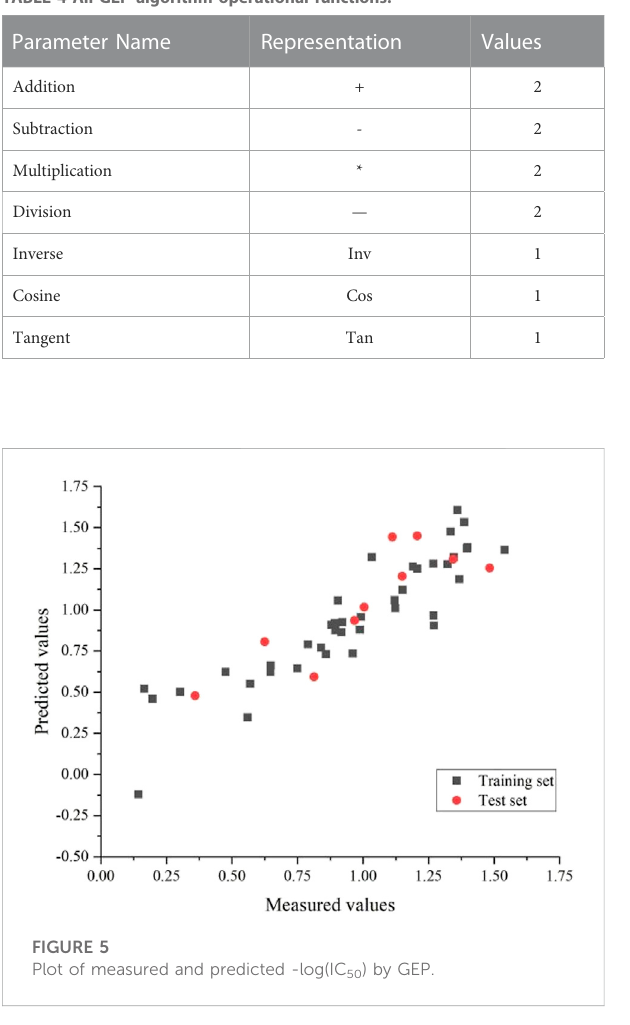
TABLE 4 All GEP algorithm operational functions.